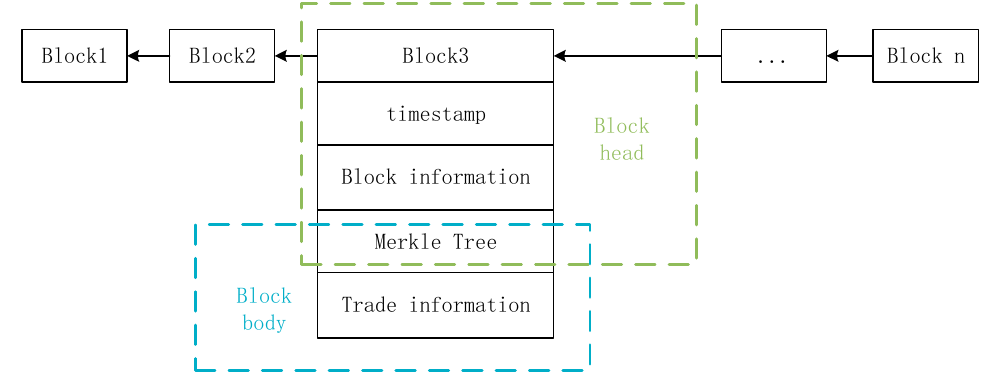
Figure 2. The basic structure of the blockchain.